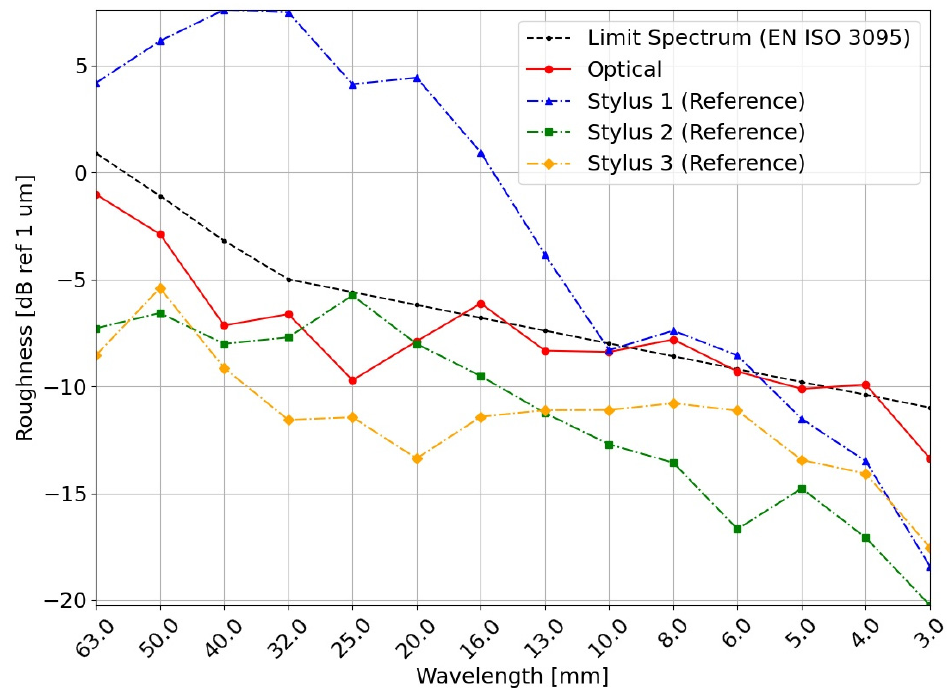
Figure 6. Spectrum of acoustic roughness for measurement of the optical system in the tunnel, compared with reference section B and the limit spectrum from EN ISO 3095 [22].